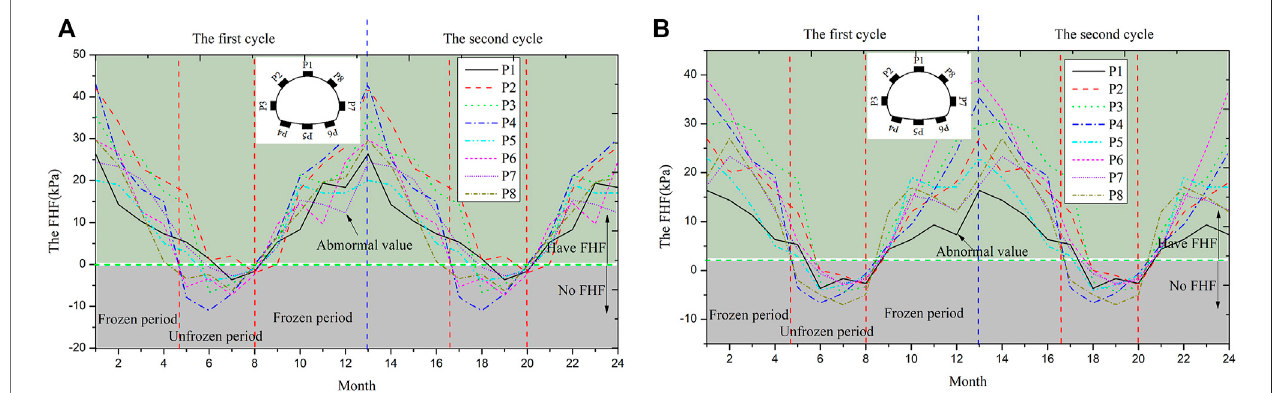
FIGURE 7 | The change law of the FHF. (A) Section 700 (B) Section 600.